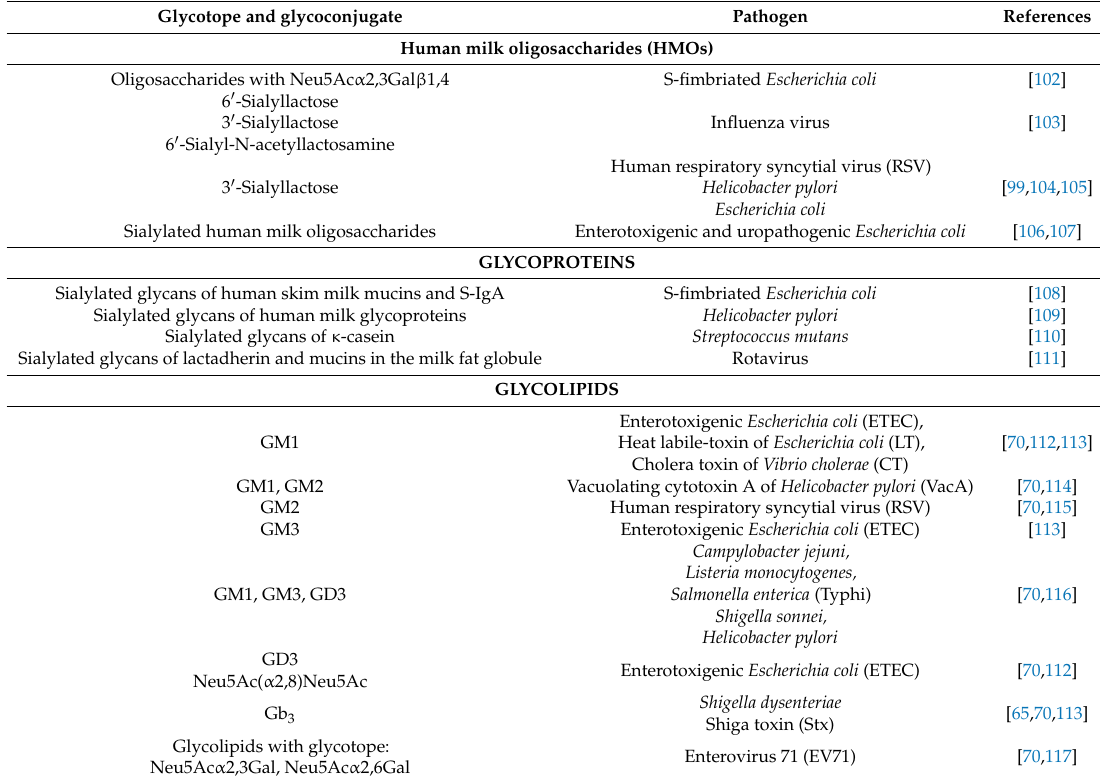
Table 1. Sialylated glycoconjugates and oligosaccharides of human milk that may inhibit pathogen and toxin adhesion to human epithelial